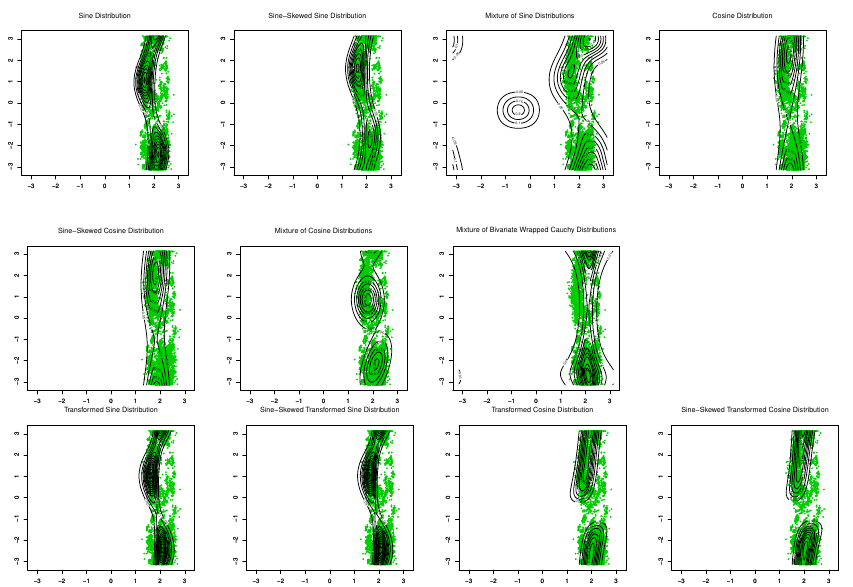
Figure 9. Contour plots of fitted pdfs together with scatter plot for SCOP.1 ( n = 10,188). The last row includes the proposed models.